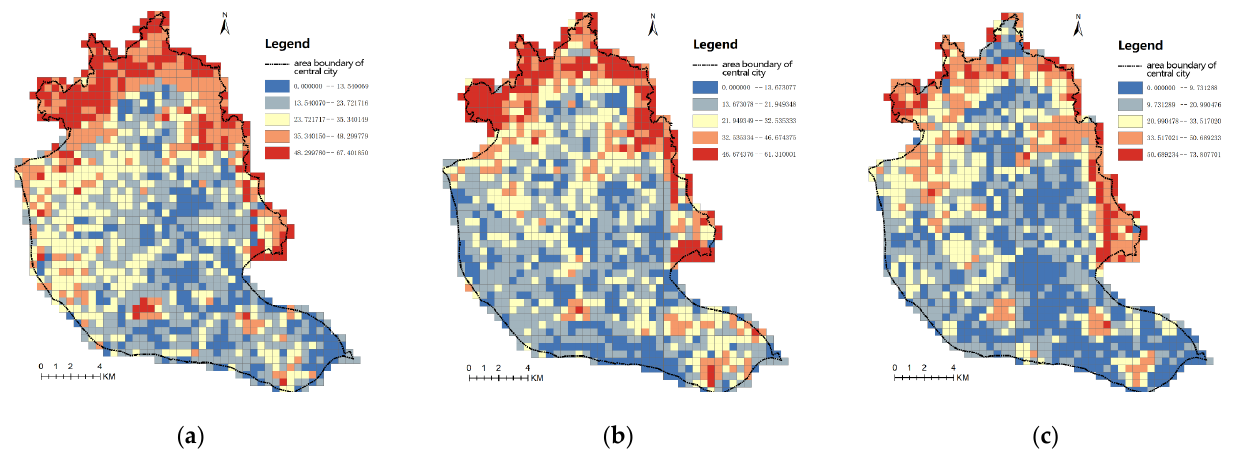
Figure 7. LSI change in the central area of Fuzhou City: ( a ) landscape shape index of 2000; ( b ) landscape shape index of 2010; ( c ) landscape shape index 2021. Red is the high LSI value; blue is the low LSI value.